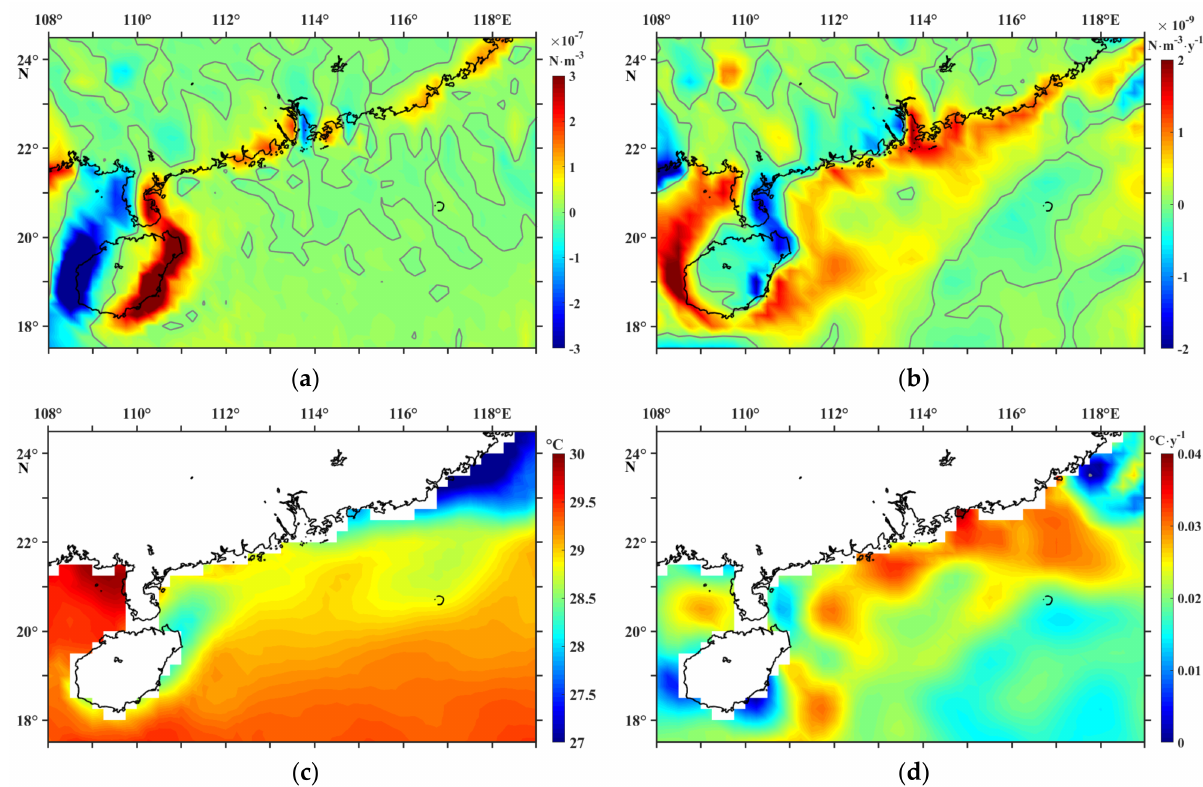
Figure 10. ( a ) Spatial distribution of the summer mean wind stress curl averaged from 1979 to 2019. ( b ) Trend of the summer mean wind stress curl. ( c ) Spatial distribution of the summer mean sea surface temperature (SST) averaged from 1979 to 2019. ( d ) Trend of the summer mean SST. The grey contours represent